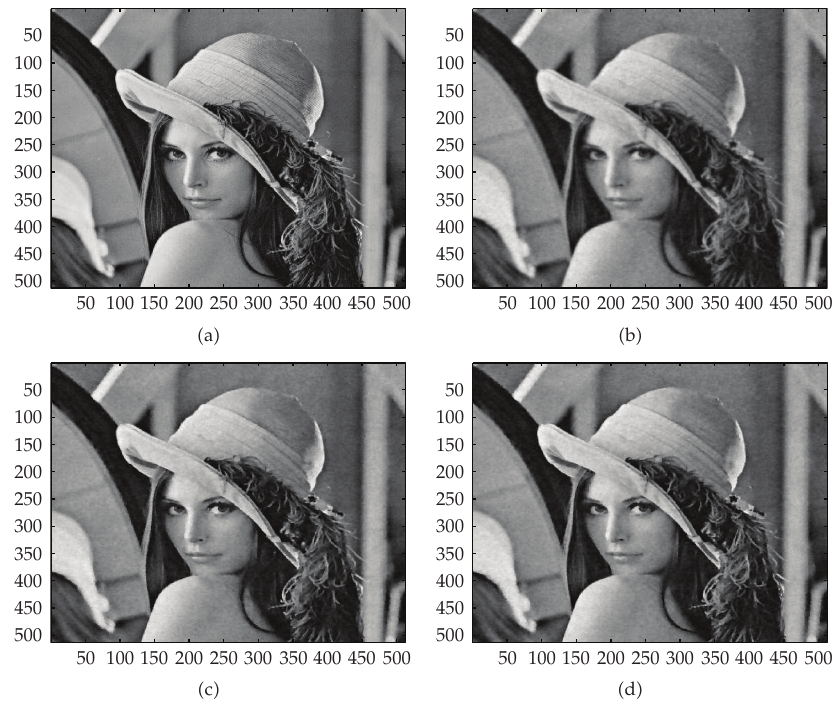
Figure 1: (cid:7) a (cid:8) Initial 512 × 512 Lena image, (cid:7) b (cid:8) restored image using the linear di ff usion method, (cid:7) c (cid:8) restored image using a nonlinear di ff usion method, and (cid:7) d (cid:8) restored image using the topological gradient